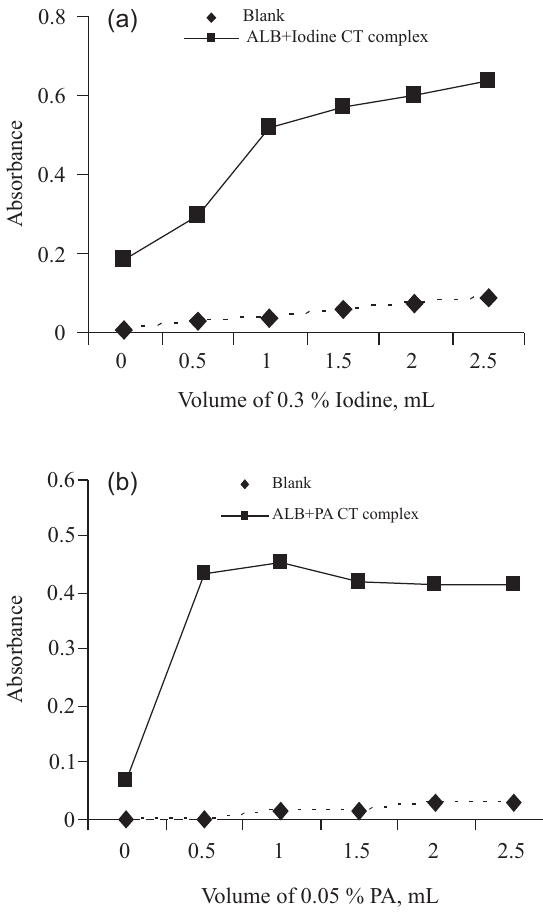
FIGURE 5 - (a) Effect of the iodine concentration for method A (120 µg mL -1 ALB); (b) Effect of the picric acid concentration for method B (30 µg mL -1